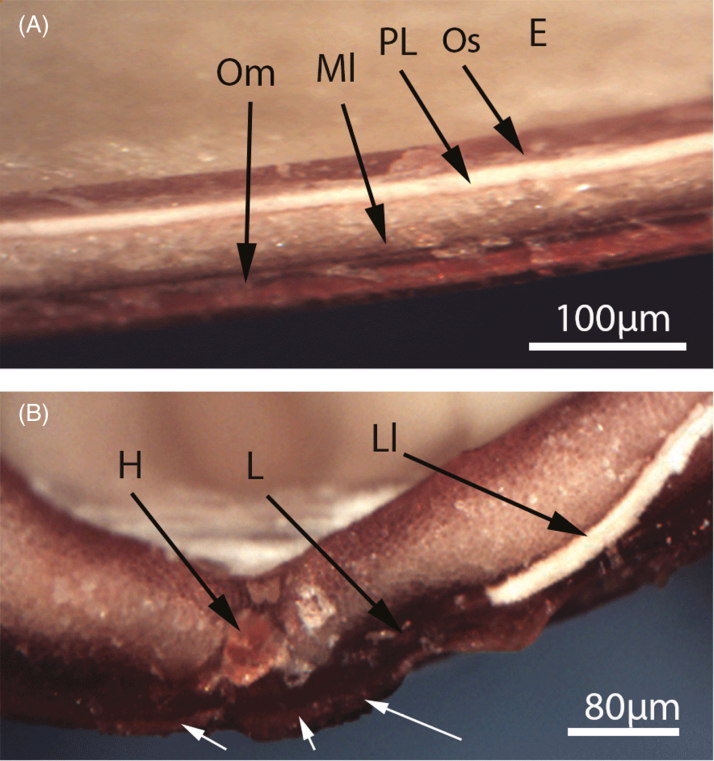
Photomicrographs of longitudinal sections of Adenanthera pavonina seed coat in (A) non-hilar region and (B) hilar region. E, endosperm; H, hilum; LI, light line; Ml, mesophyll layer; Om, outer macrosclerids; Os, osteosclerids; PL, palisade layer. White arrows mark the thin palisade layer on the hilar surface.